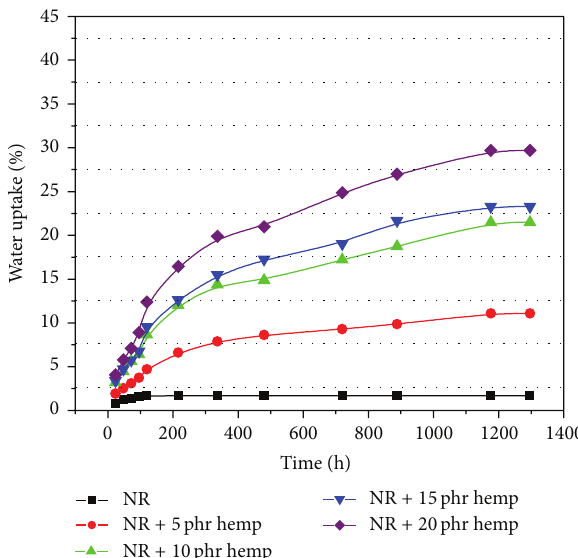
Figure 9: Water uptake of polymeric composites at absorbed dose of 300 kGy.